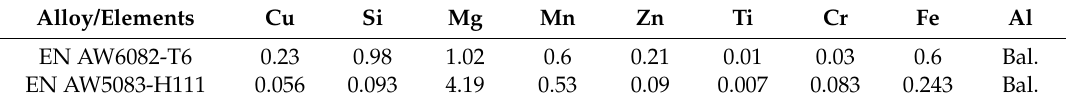
Table 2. Mechanical properties of aluminum alloys.